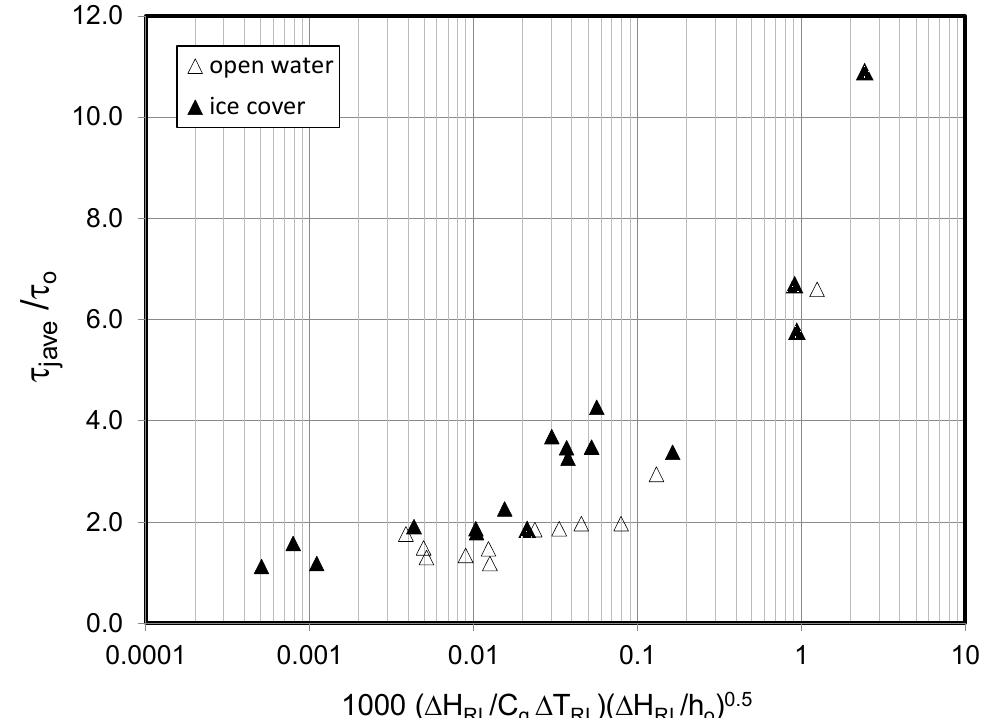
Figure 3. Shear stress amplification ratio versus a product-combination of independent dimensionless variables for javes propagating in open-water and in ice-covered reaches. Symbols: τ jave , approximate peak bed shear stress; τ o , pre-jave shear stress; Δ H RL , wave height; Δ T RL , duration of rising limb. Adapted from [3]. Crown copyright, published by Elsevier.